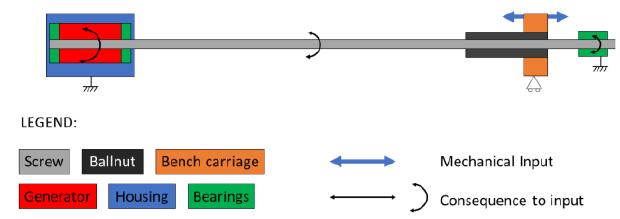
Fig. 1. WEC-Sim model for the OWSC concept with more EMGs in parallel configuration. Fig. 2. Selected concept for the EMU